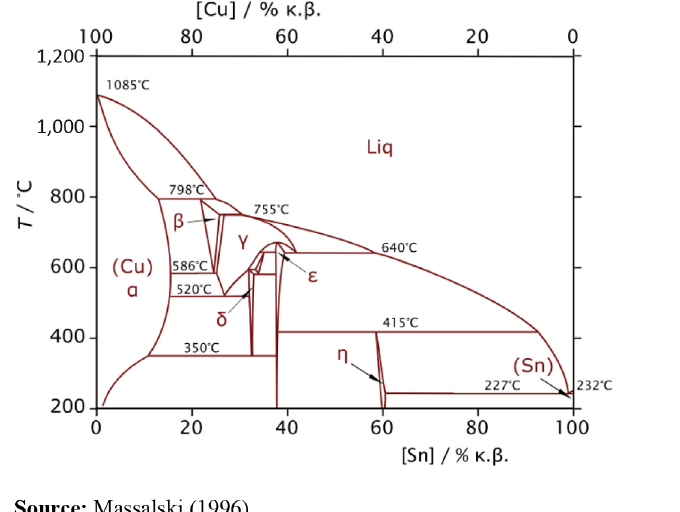
Figure 15. Binary Cu-Sn phase